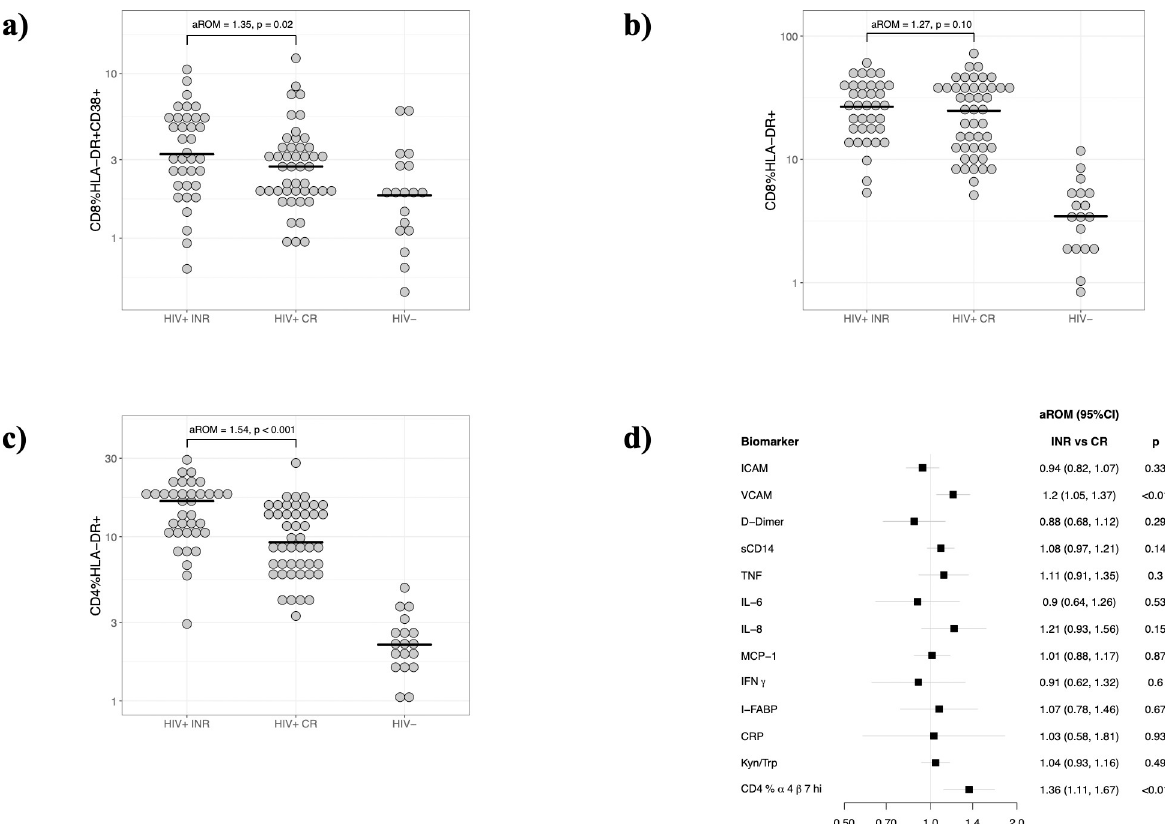
Fig 1. Characterizing immune differences between INR and CR groups. T cell activation was compared between INR, CR and HIV-uninfected groups based on (a) CD8+ T cell co-expression of HLA-DR and CD38; (b) CD8+ T cell expression of HLA-DR; and (c) CD4+ T cell expression of HLA-DR. Y-axis demonstrates % expression; the adjusted ratio of means (aROM) and p-value reflect a multivariable analysis controlling for age, sex, duration of ART, and recent infection/vaccination. (d) Additional analyses compared plasma and cellular markers of immune activation, gut damage, coagulopathy, and gut